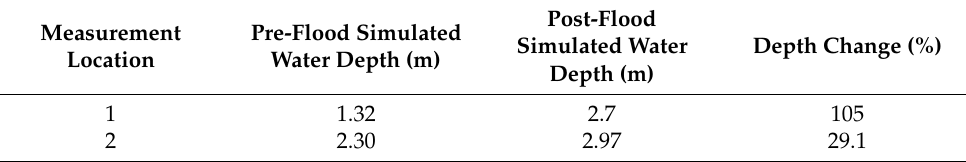
Table 3. A comparison of the water depth from the HEC-RAS simulation using pre-flood and post-flood